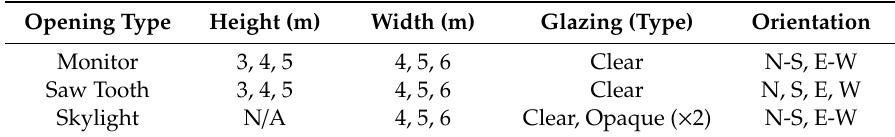
Table 1. Breakdown of the 72 cases studies that were